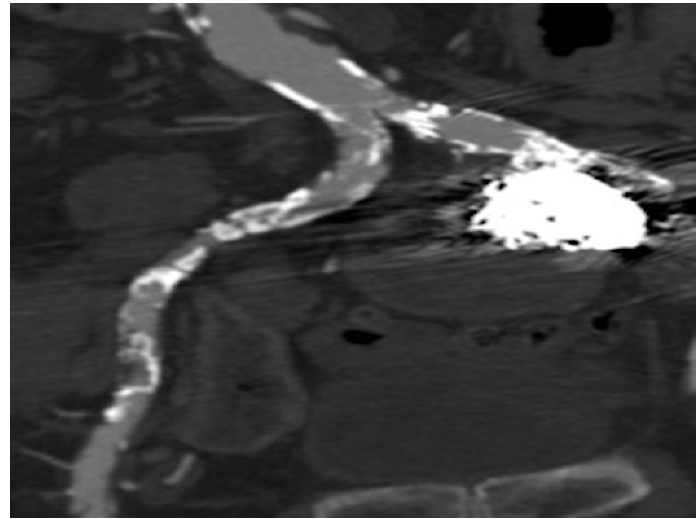
Figure 4. Post-embolization follow-up coronal CTA with contrast demonstrated complete closure of the pseudoaneurysm.